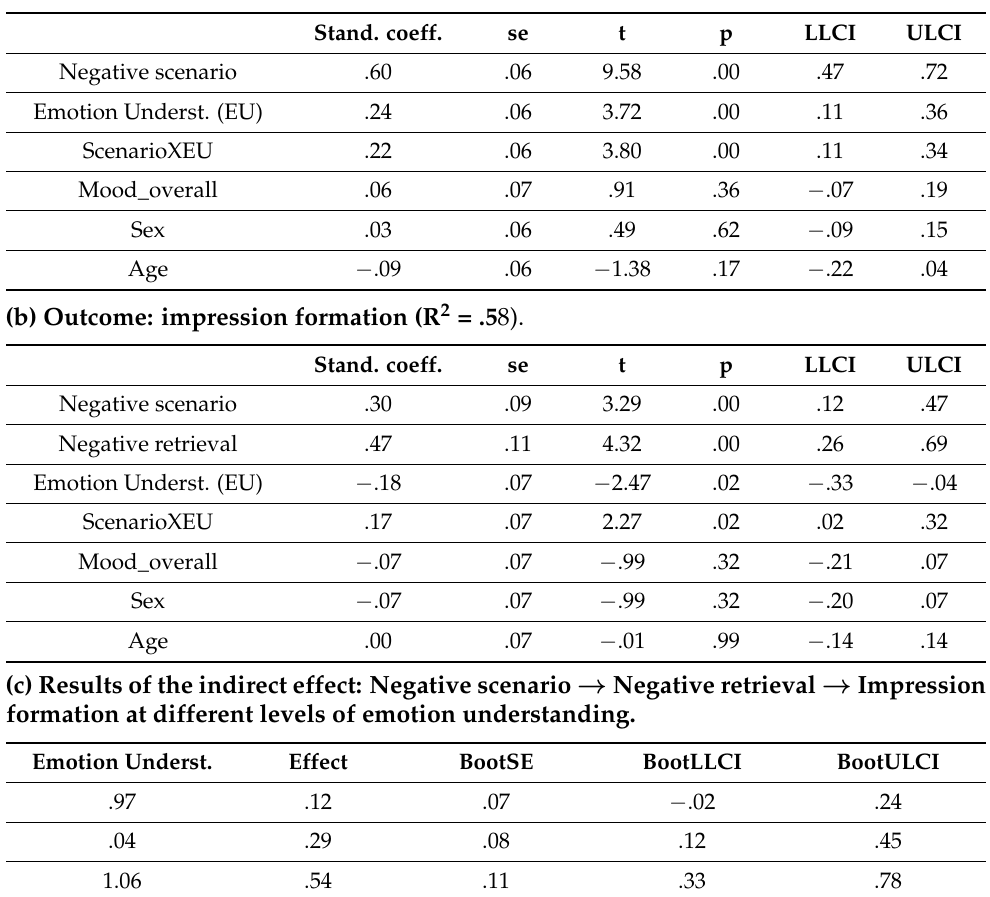
(c) Results of the indirect effect: Negative scenario → Negative retrieval → Impression formation at different levels of emotion understanding. Emotion